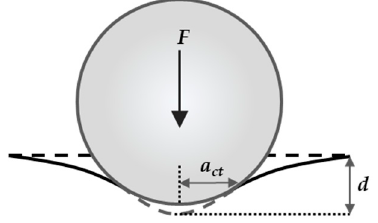
Figure 4. Definition of the radius of the contact area ( a ct ) .